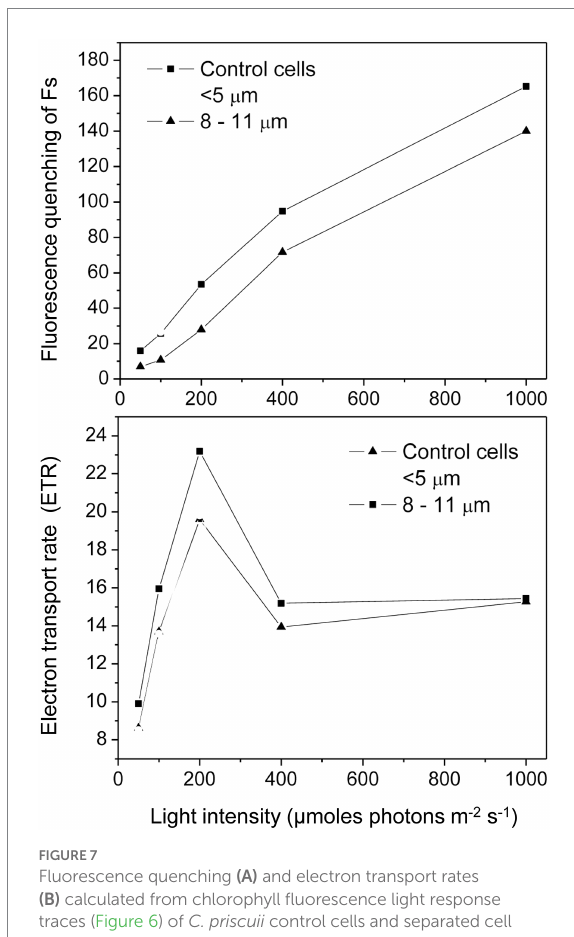
FIGURE 7 Fluorescence quenching (A) and electron transport rates (B) calculated from chlorophyll fluorescence light response traces (Figure 6) of C. priscuii control cells and separated cell fractions, measured at increasing actinic light (AL) intensities of 50, 100, 200, 400 and 1,000 μ mol photons m − 2 s − 1